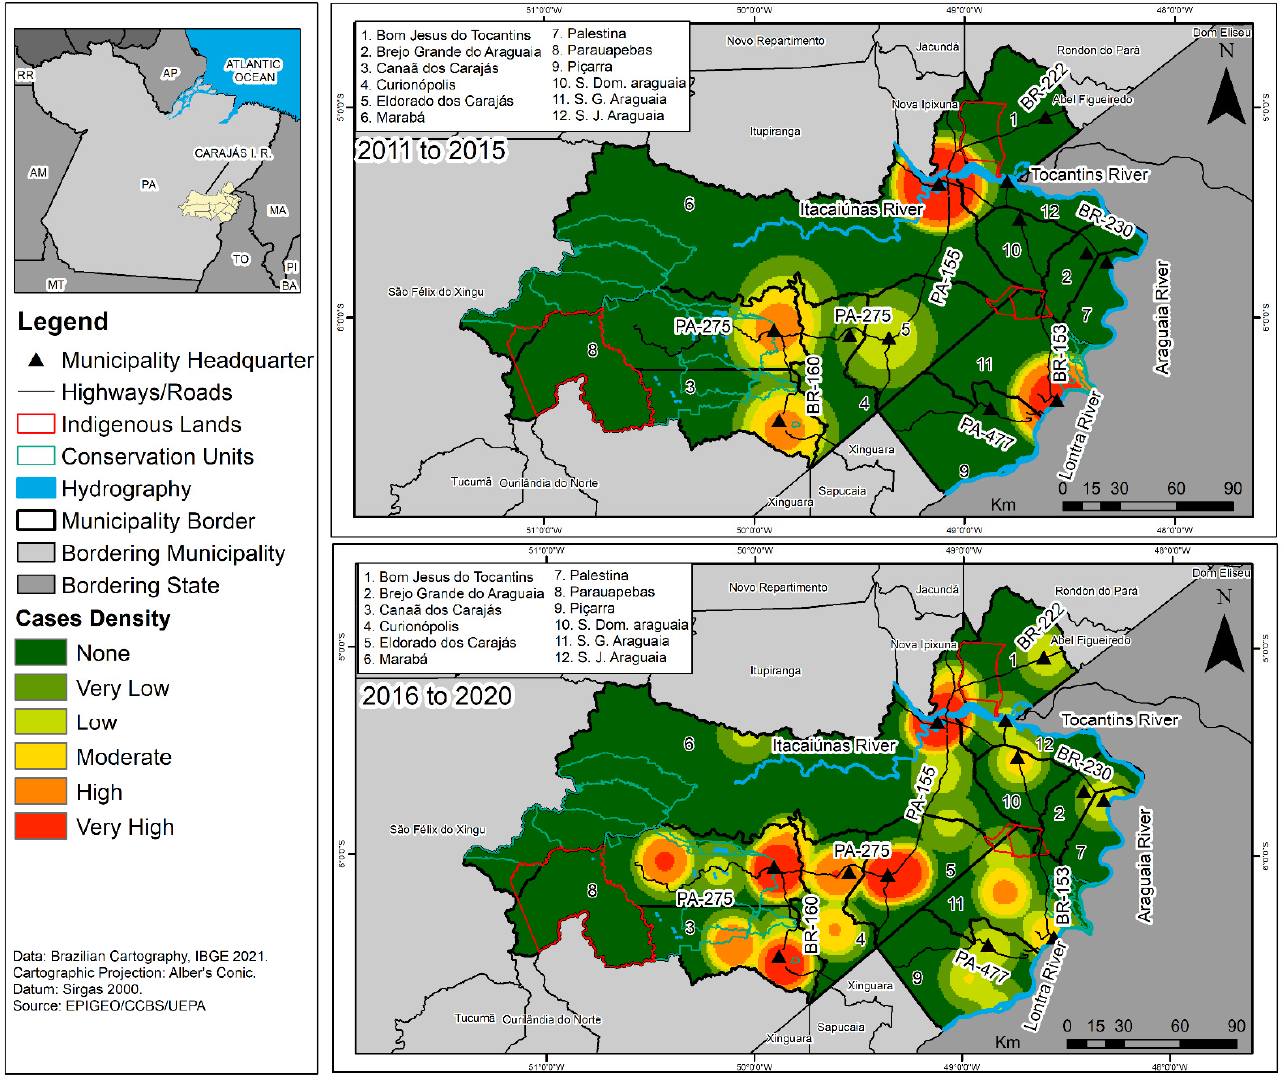
Figure 3. Cases density of human visceral leishmaniasis in the Carajás Integration Region, Pará, Brazil, for the period of 2011 to 2020.